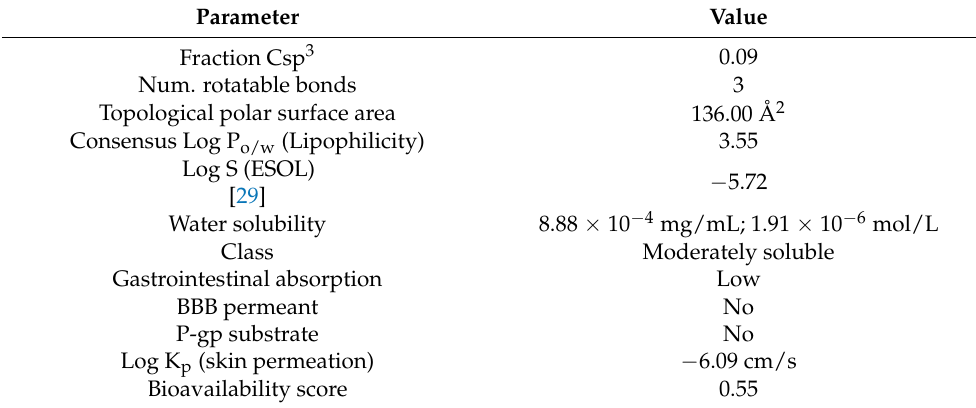
Figure 4. The ‘BOILED-Egg’ diagram for chromeno[2,3- b ]pyridine ( 4 ). Some of the calculated ADME parameters are presented in Table 1. It also follows from and Muegge [28] rules. Table 1. Calculated ADME parameters of synthesized chromeno[2,3- b ]pyridine ( 4 ).